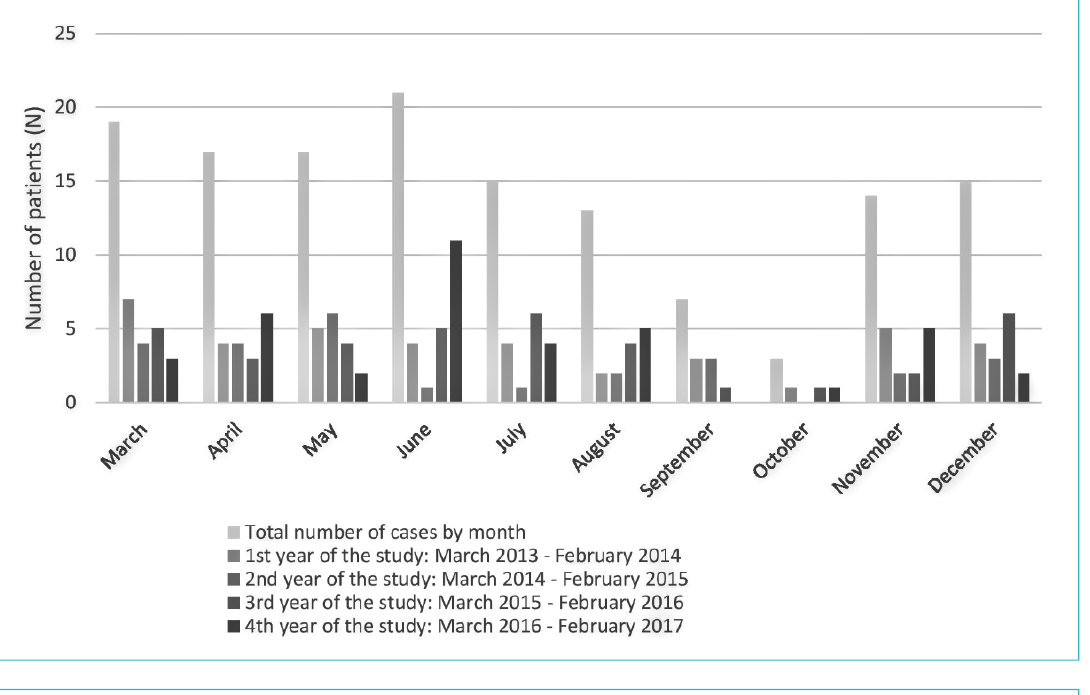
Figure 3: Bar chart showing the seasonality of Kawasaki disease in Switzerland, with a nadir in September and October.